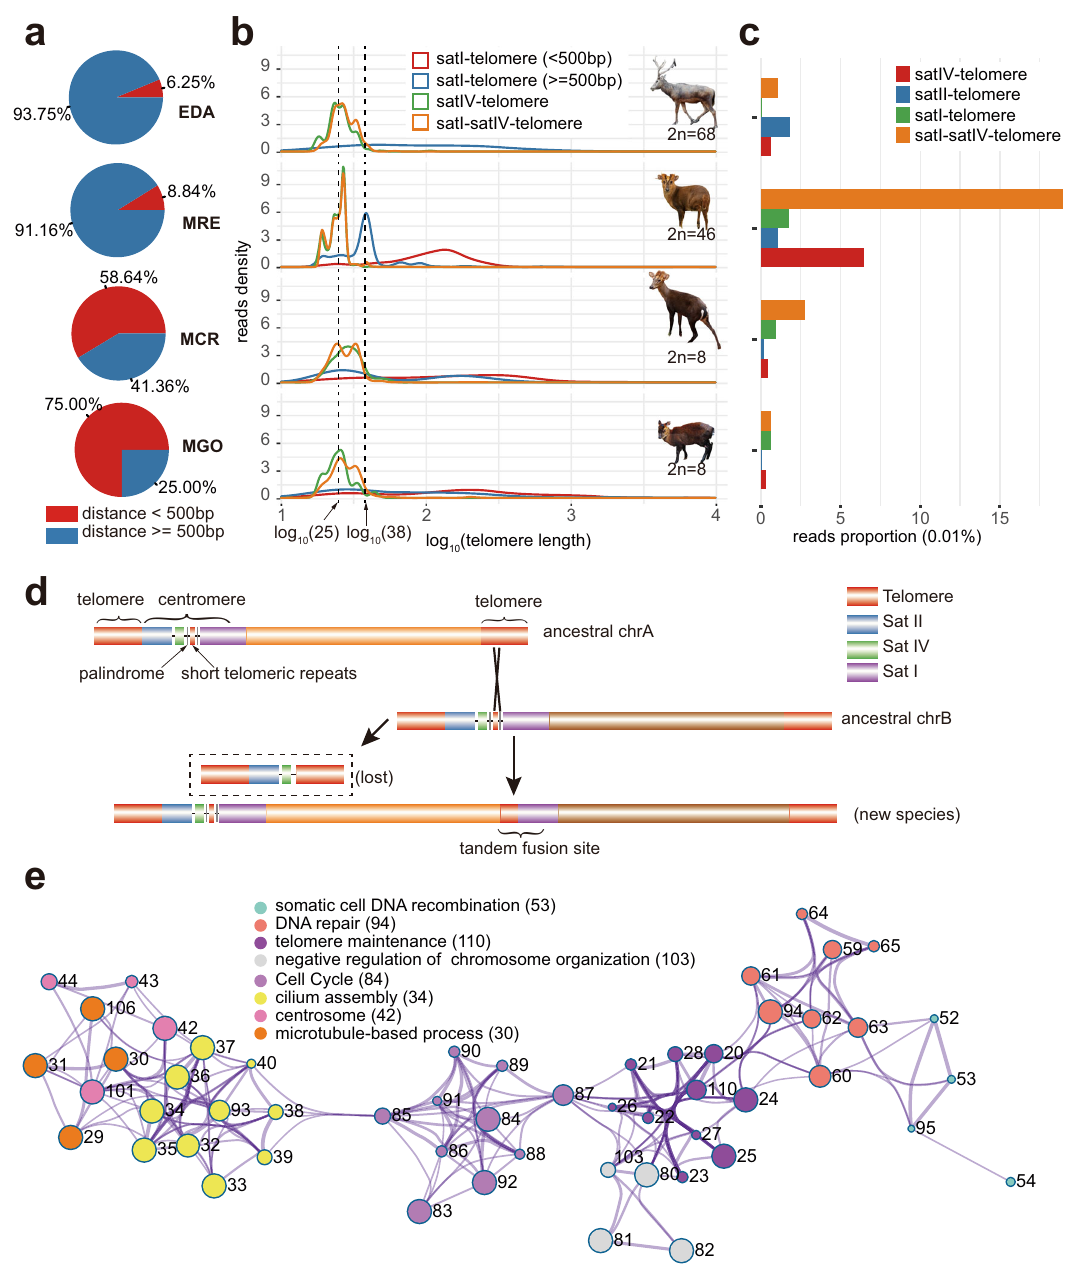
Fig. 3 Molecular basis of tandem chromosome fusion of muntjac species. a Proportion of reads with distance between satellite I and telomeric repeats smaller (red) or longer (blue) than 500 bp. Only reads containing telomeric sequences and satellite I but not satellite II and IV are considered in this statistic. EDA, E. davidianus ; MRE, M. reevesi ; MCR, M. crinifrons ; MGO, M. gongshanensis . b Kernel density estimate of reads with different length of telomeric sequence. Reads containing different combinations of satellite and telomeric sequence are displayed separately with colored lines. satI, satellite I; satIV, satellite IV; telomere, telomeric sequence. The top-to-bottom of species order is consistent with that of Fig. 3a. c Proportion of reads containing different combinations of satellite or telomeric repeats in all investigated reads of E. davidianus , M. reevesi , M. crinifrons , and M. gongshanensis . d Schematics of a conjectural mechanism of tandem fusion. DNA double-strand breaks occurred at palindromes nearby the short telomeric repeats, which mediated nonallelic homologous recombination between different ancestral muntjac chromosomes and led to the tandem fusions. e Network plot of GO terms enriched by REGs and PSGs of M. gongshanensis . REGs and PSGs are pooled in the GO enrichment analysis and each GO term is numbered. GO terms with a similarity >0.3 are connected by edges. Circles with the same color represent that GO terms belong to the same cluster. The size of each circle re fl ects the p value, where terms containing more genes tend to have a more signi fi cant p value. For each cluster, we display the name and number of a representative GO term. Only clusters related to cell cycle, nuclear division, DNA damage response or telomere maintenance are displayed of candidate male-speci fi c mutations are in the neo-Y regions deletions (indels) of male M. crinifrons individuals than those of (Fig. 4a, b, and Supplementary Fig. 22a, b), in sharp contrast to female in the homologous neo-sex regions but not in the rest of the sequence proportion of neo-Y region in the whole-genome the genome (Fig. 4a, track D), indicating the early divergence (15.37%). Based on the distribution of candidate male-speci fi c between neo-Y and neo-X. In detail, we found that most (66.46%)